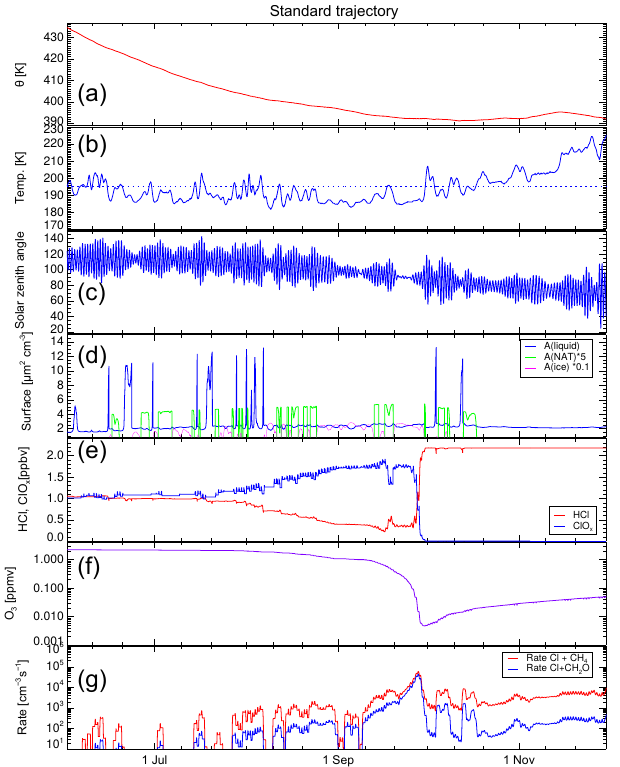
Figure 1. Box-model simulations along a trajectory passing through the location of the ozone sonde observation at South Pole of 14ppb on 74hPa (391K) on 24 September 2003 (Grooß et al., 2011). The different panels show a time series of the relevant parame- ters: (a) potential temperature of the air parcel, (b) temperature, (c) solar zenith angle, (d) surface area density of ice (red, scaled by 0.1), NAT (green, scaled by 5) and liquid aerosol particles (blue), (e) ClO x (blue) and HCl (red), (f) ozone, and (g) rates of reaction of atomic chlorine with CH 4 (blue) and CH 2 O (red). For reasons of clarity, the reaction rates in panel (g) are plotted as 24h running averages. The model simulation covers the time period from 1 June to 30 November